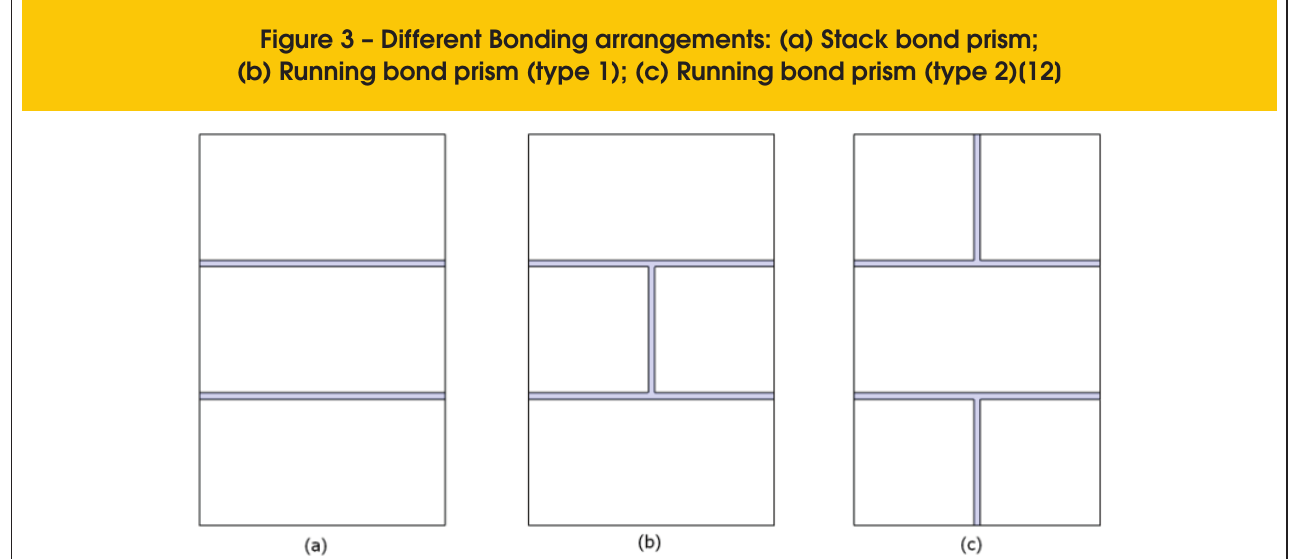
Figure 3 – Different Bonding arrangements: (a) Stack bond